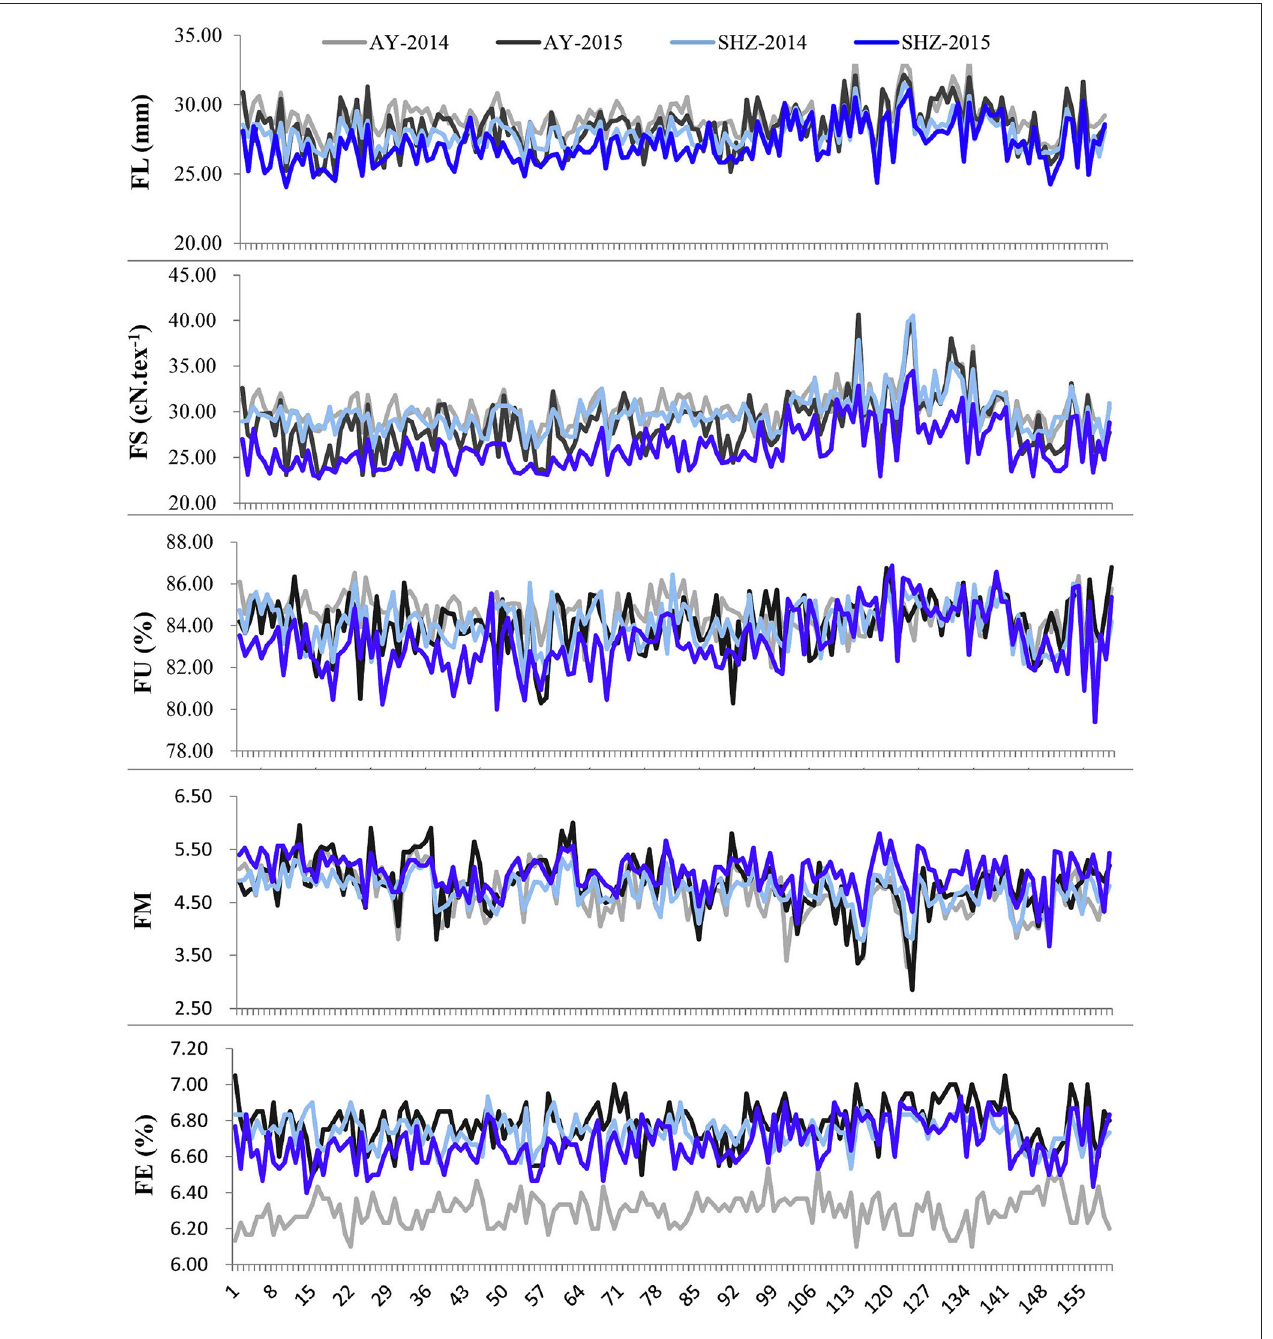
FIGURE 1 | Phenotypic distributions of five fiber-quality related traits of 160 early-maturity upland cotton accessions in four cultivating